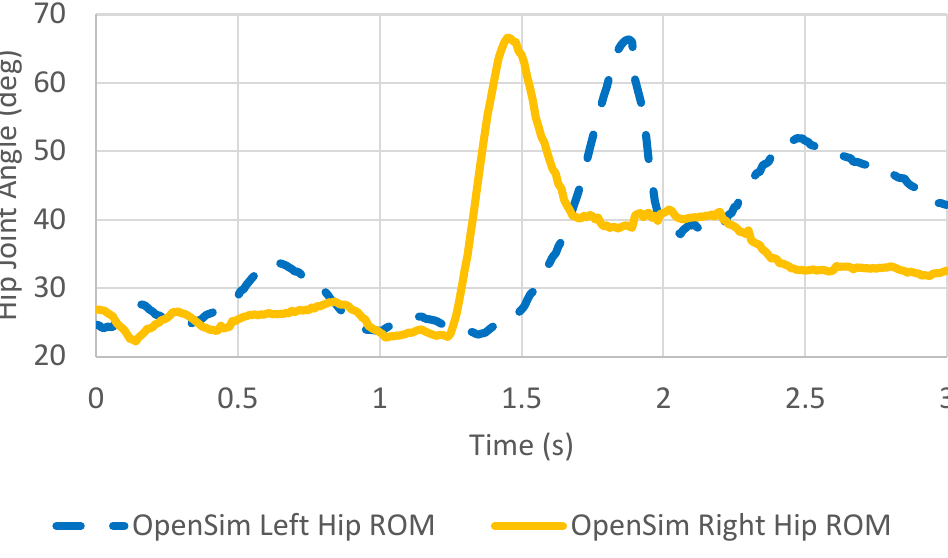
Figure 4. Hip joint angle data during discrete isolated kicks for right and left hips. 3.2. Hip Joint Moment The correlating hip joint moment results of the discrete kicks for the right and left hip joints are shown in Figure 5 and are consistent with the observed hip ranges of motion. Figure 5 shows that the maximum torque is required at the beginning of the kick cycle when the hip joint torque must overcome the gravitational force to reach maximum flexion. Once the gravitational force is overcome, the moment decreases to slow down the motion as it reaches maximum flexion. Similarly, the moment increases as the motion reverses as it goes into extension where the maximum torque is needed at the end of the kick cycle to slow down the hip joint.